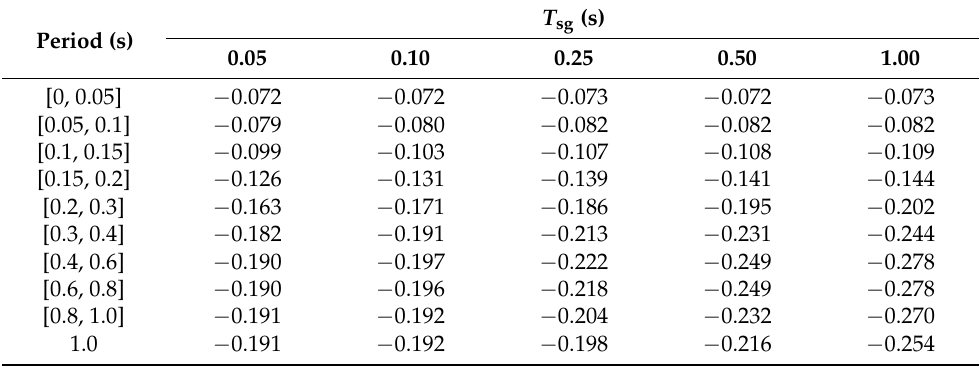
Table A4. Maximum frequency deviations (Hz) ( T sg was changed).